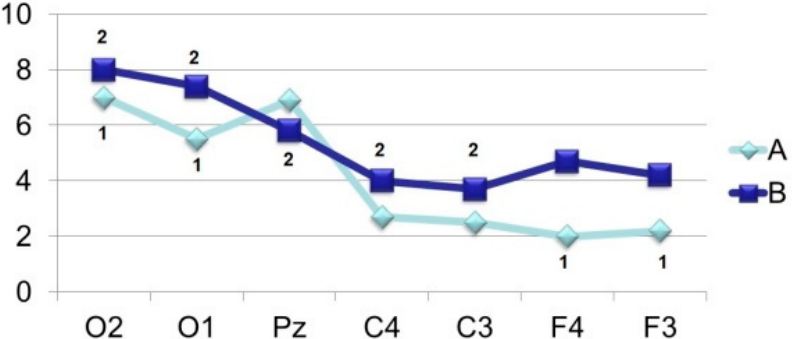
Figure 3. Averaged values of amplitudes and factor characteristics of amplitudes and PL of the N 70 ERP component during the perception of recognizable (A) and unrecognizable (oddball) (B) images. On the abscissa–points according to the 10–20 system, on the ordinate–amplitude, uV. Figures on the graphs: 1–maximum factor number for amplitude, 2–maximum factor number for PL.